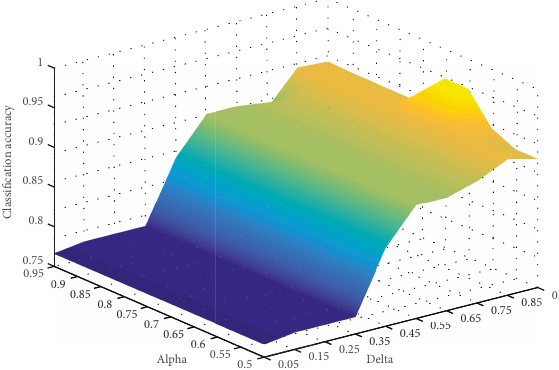
Figure 5: Classi fi cation accuracy with δ and α on anneal.